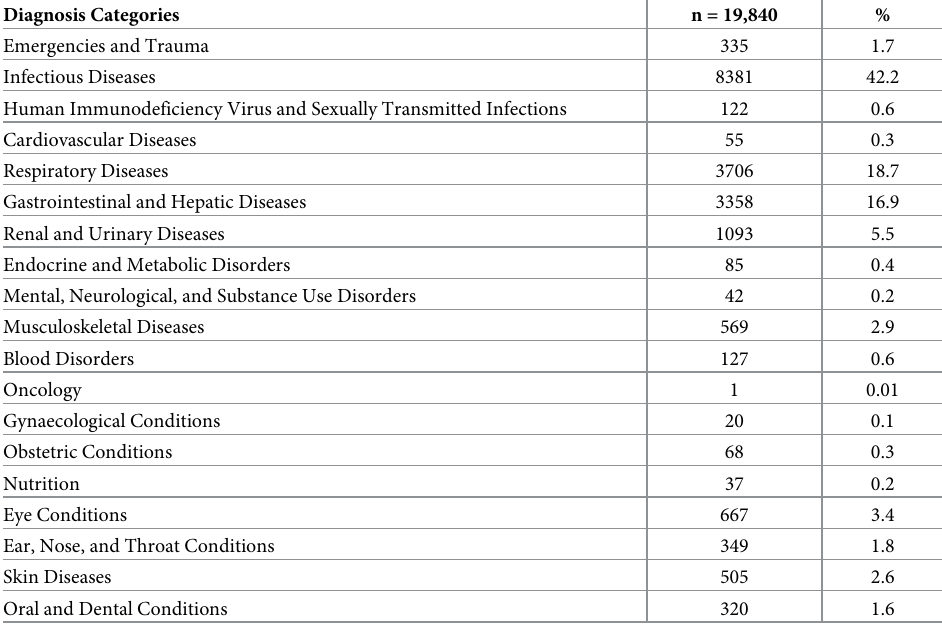
Table 2. Diagnosis categories treated at AYPC in